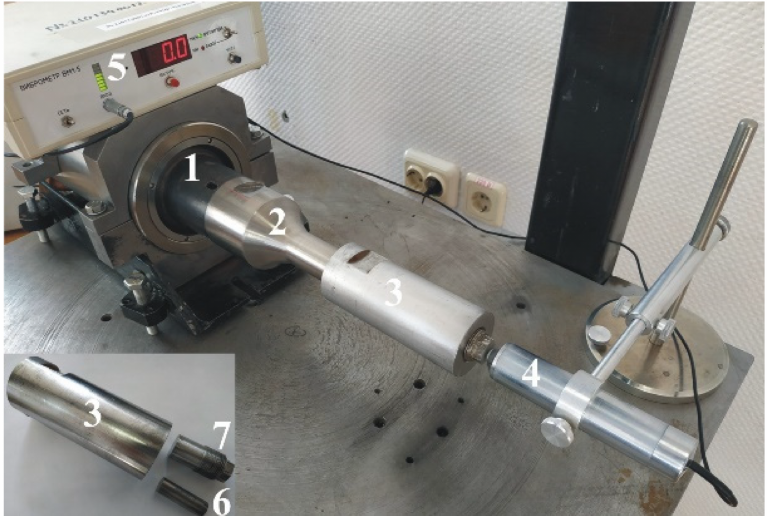
Figure 4. An example of equipment for ultrasonic treatment: ultrasonic transducer (1), concentrator (2), waveguide with a sample (3), capacity sensor (4), amplitude-detecting device (5), sample (6) and clamping cylinder (7)